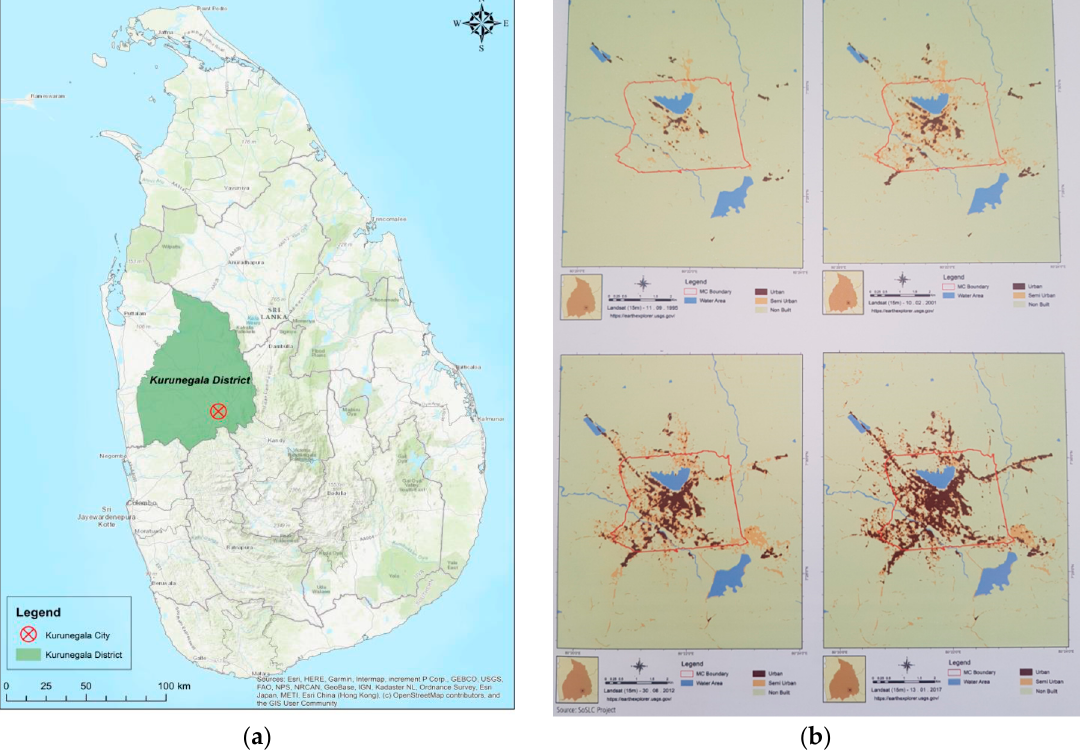
Figure 1. Location of Kurunegala ( a ) and the expansion in Kurunegala city ( b ) (1995–2017) (The state of Sri Lankan Cities, 2018).